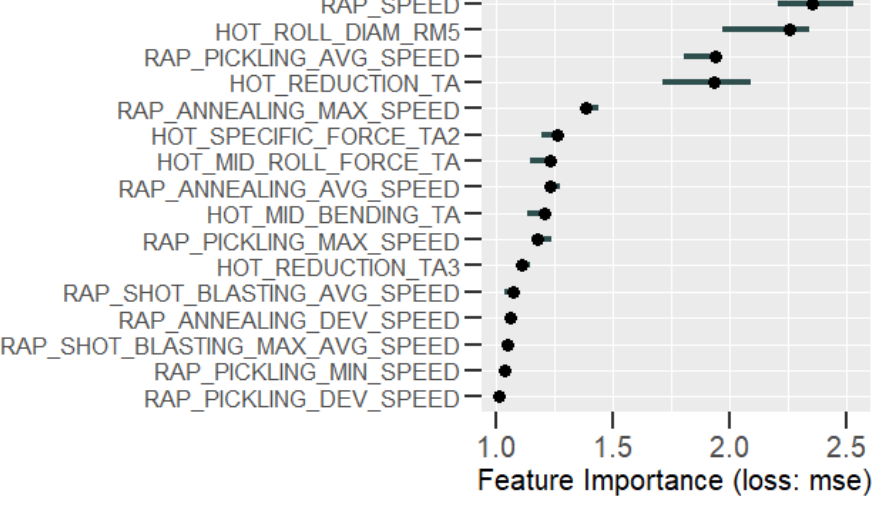
Figure 6. Variable importance for